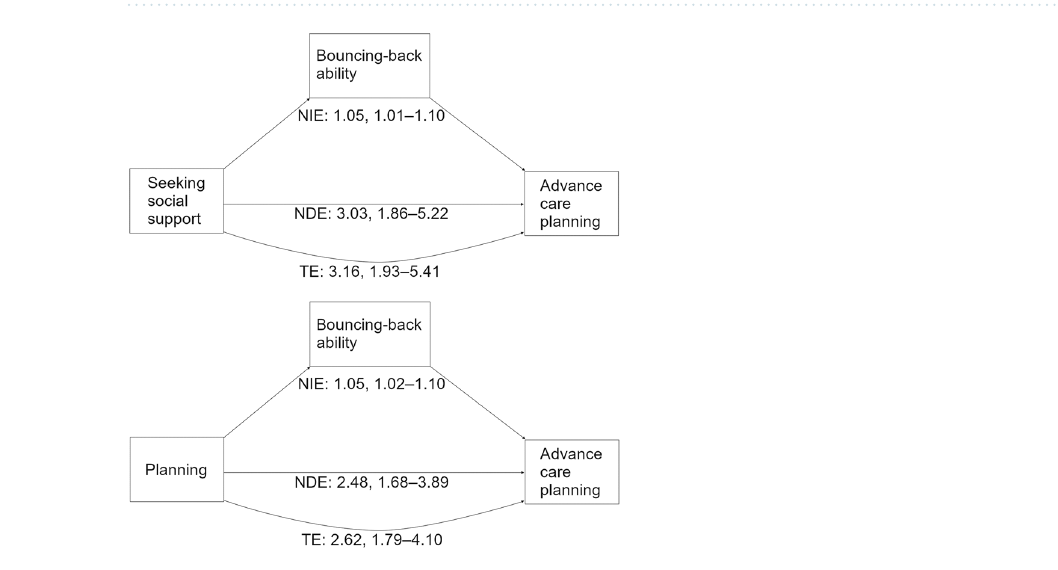
Figure 2. Mediation process and results regarding stress coping on advance care planning discussions through bouncing-back ability. NIE natural indirect effect, NDE natural direct effect, TE total effect. The upper and lower diagrams in the figure show models regarding stress coping related to seeking social support and planning on advance care planning discussions through bouncing-back ability, respectively. The numbers in the figure indicate ORs and bias-corrected bootstrapped 95% CIs representing the natural direct and indirect effects and the total effect. The models included age, sex, comorbidities, caregiving experience, religious beliefs, and COVID-19 incidence as